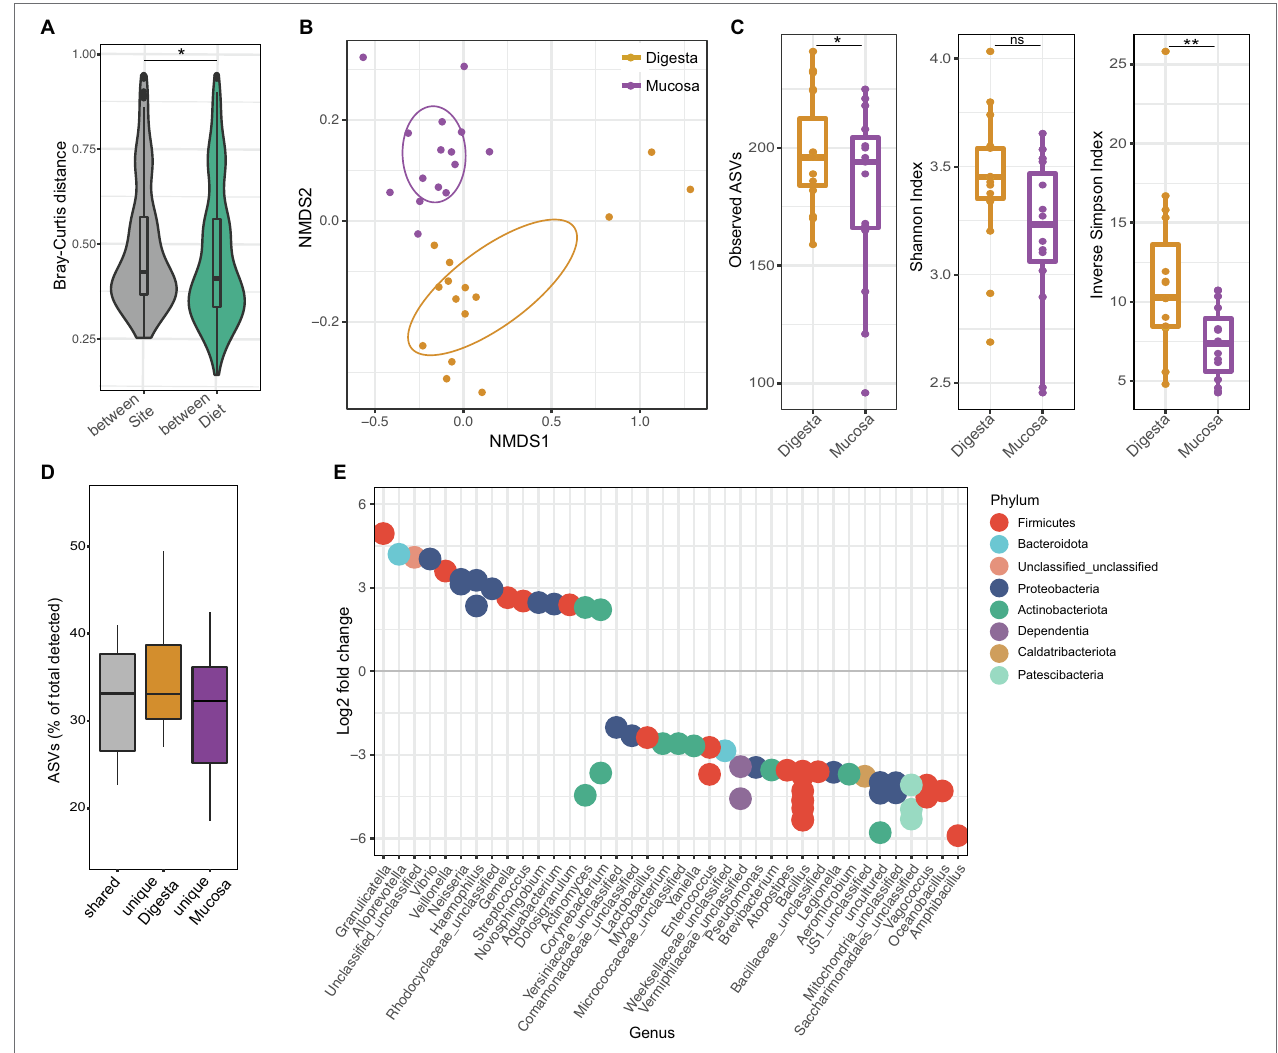
FIGURE 2 | Sampling site as a driver of gut microbial community composition. (A) Violin plot representing the calculated Bray–Curtis distances between samples originating from different sampling intestinal sites (grey) or between samples originating from fish fed different diets (green). * p = 0.031; Wilcoxon test. (B) Ordination plot based on non-metric multidimensional scaling analysis of Bray–Curtis distances at the ASV level. SD ellipses and point dots representing each sample are depicted and are colored by sampling intestinal site. Stress = 0.057. (C) Alpha diversity metrics (number of Observed ASVs, Shannon Index, and Inverse Simpson Index) of the mucosa and digesta samples. Each point represents one sample ( n = 15 paired mucosa and digesta samples). * p = 0.041; ** p = 0.008; ns = non- significant; paired Wilcoxon test. (D) Percentage of total ASVs detected in samples originating from the same tank that are shared between the mucosa and corresponding digesta sample, or unique to sampled site. (E) Differential abundant ASVs based on DESeq2 analysis (adjusted value of p < 0.05, Wald test followed by Benjamini–Hochberg correction for multiple testing) between mucosa and digesta samples (Log2 fold change >2 denotes enrichment in mucosa; Log2 fold change < − 2 denotes enrichment in digesta). ASVs are assigned to genus ( x -axis) and colored by phylum. In (A,C,D) boxes represent median, first and third quartile. Whiskers extend to the highest and lowest values that are within one and a half times the interquartile